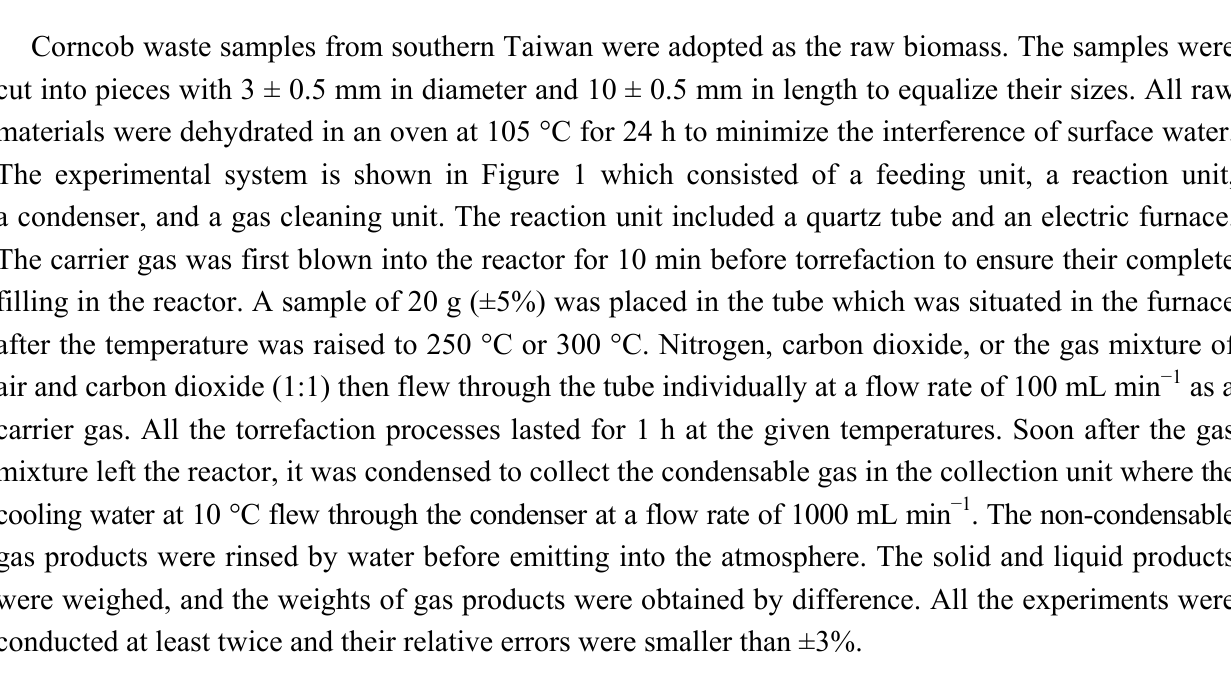
Figure 1. A schematic of experimental